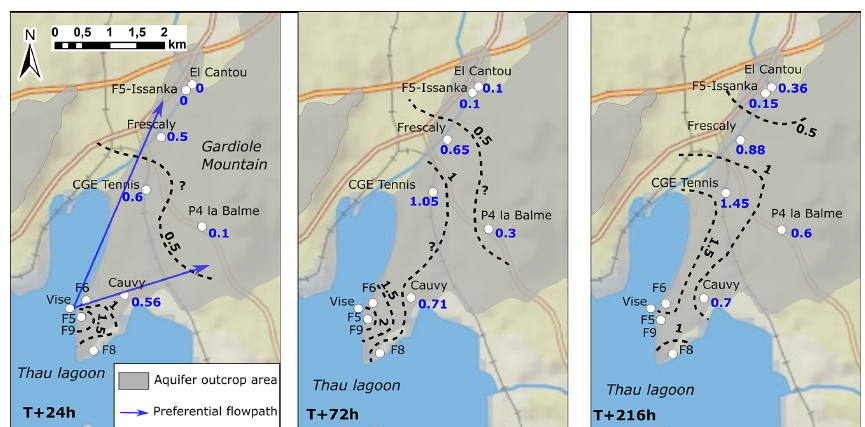
Figure 4. Spatial propagation of the hydraulic perturbation (hydraulic head increase in metres) across the Balaruc-les-Bains peninsula during the 2014 inversac event at three times after initiation: T + 24, T + 72, and T +